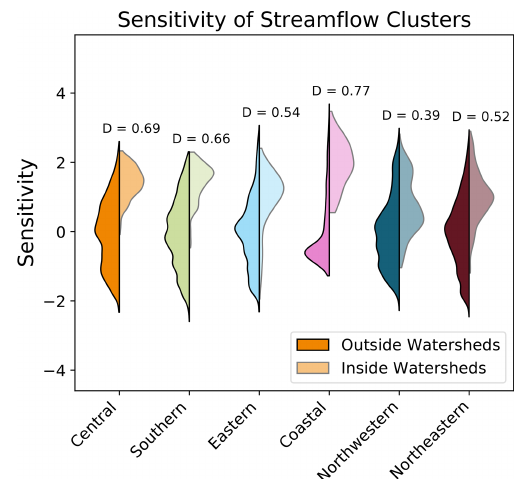
Figure 8. The sensitivity distributions for inside/near and out- side/far from the cluster watersheds. Distribution pairs are labelled by their corresponding D statistic from the Kolmogorov–Smirnov test. Clusters are coloured according to Fig. 2, and the cluster wa- tershed regions are shown in Fig. A7. While all clusters are more sensitive to perturbations within/near their watershed regions, the coastal cluster demonstrates the greatest difference in sensitivity be- tween within/near the watersheds and the rest of the